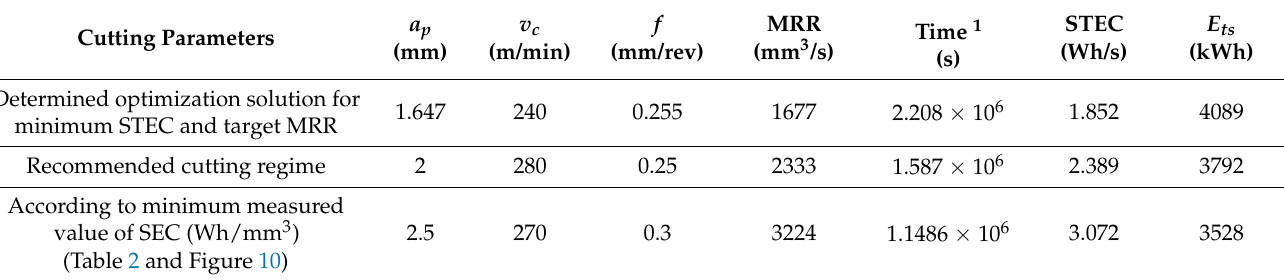
Table 6. Comparison of obtained results for different cutting parameters’